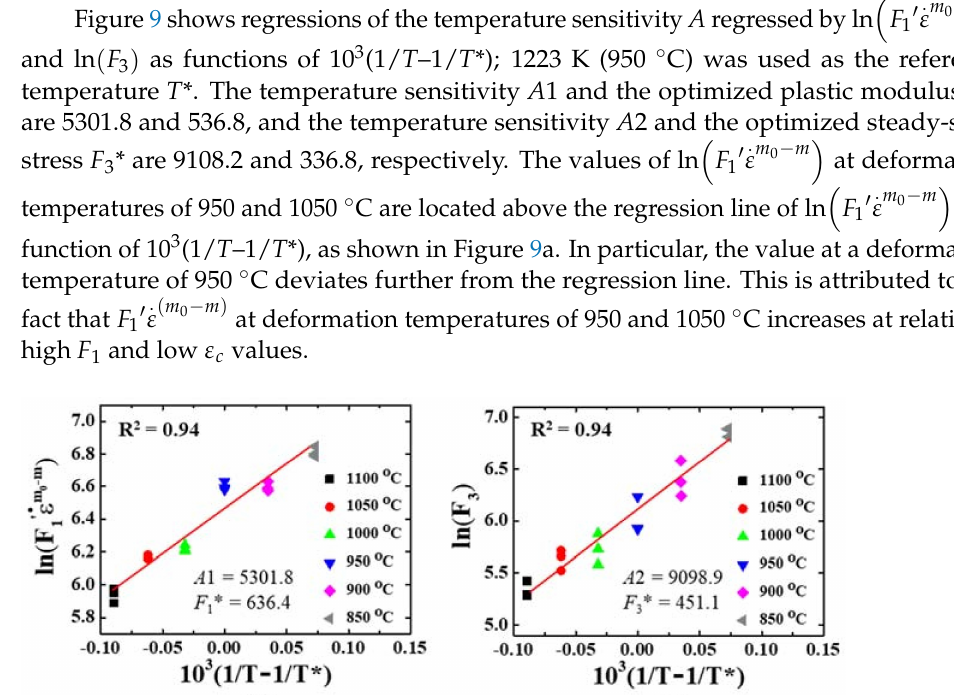
Figure 9. Temperature sensitivity A and each optimized stress regressed by ( a ) ln ln ( F 3 ) as functions of 10 3 (1/ T – 1/ T *) with reference temperature T * = 1223 K (950 ◦